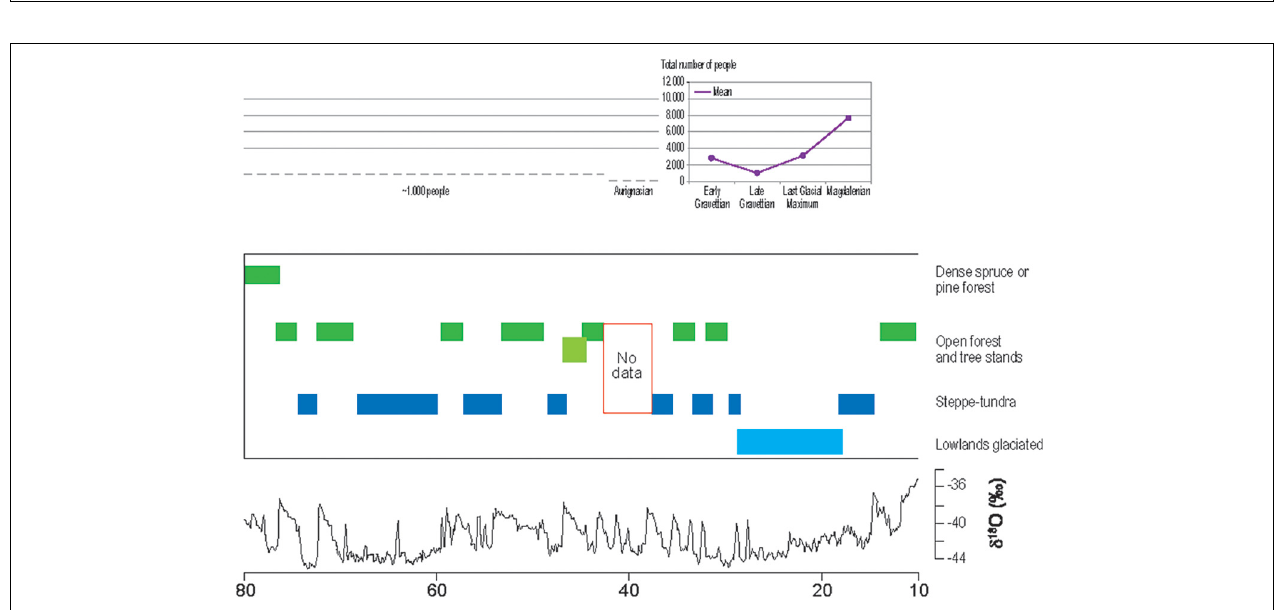
FIGURE 2 | Vegetation and palaeoclimatic development in comparison to the estimated population from c. 80 to 10 ka (x axis). According to Heiri et al. (2014), with additional palaeobotanical data (Müller et al., 2003) and estimated total number of people for the Upper Danube region until c. 42 ka (Müller-Beck, 1983), for the same region during the Aurignacian until c. 33 ka (Schmidt and Zimmermann, 2019), the early Gravettian until c. 29 ka and late Gravettian until c. 25 ka (Maier and Zimmermann, 2017), the LGM (Maier et al., 2016), and Magdalenian (Kretschmer, 2015; Maier, 2017). The Greenland ice core oxygen isotope record NGRIP is shown in the lower part of the figure according to Svensson et al. (2008), supplemented by Rasmussen et al. (2014).